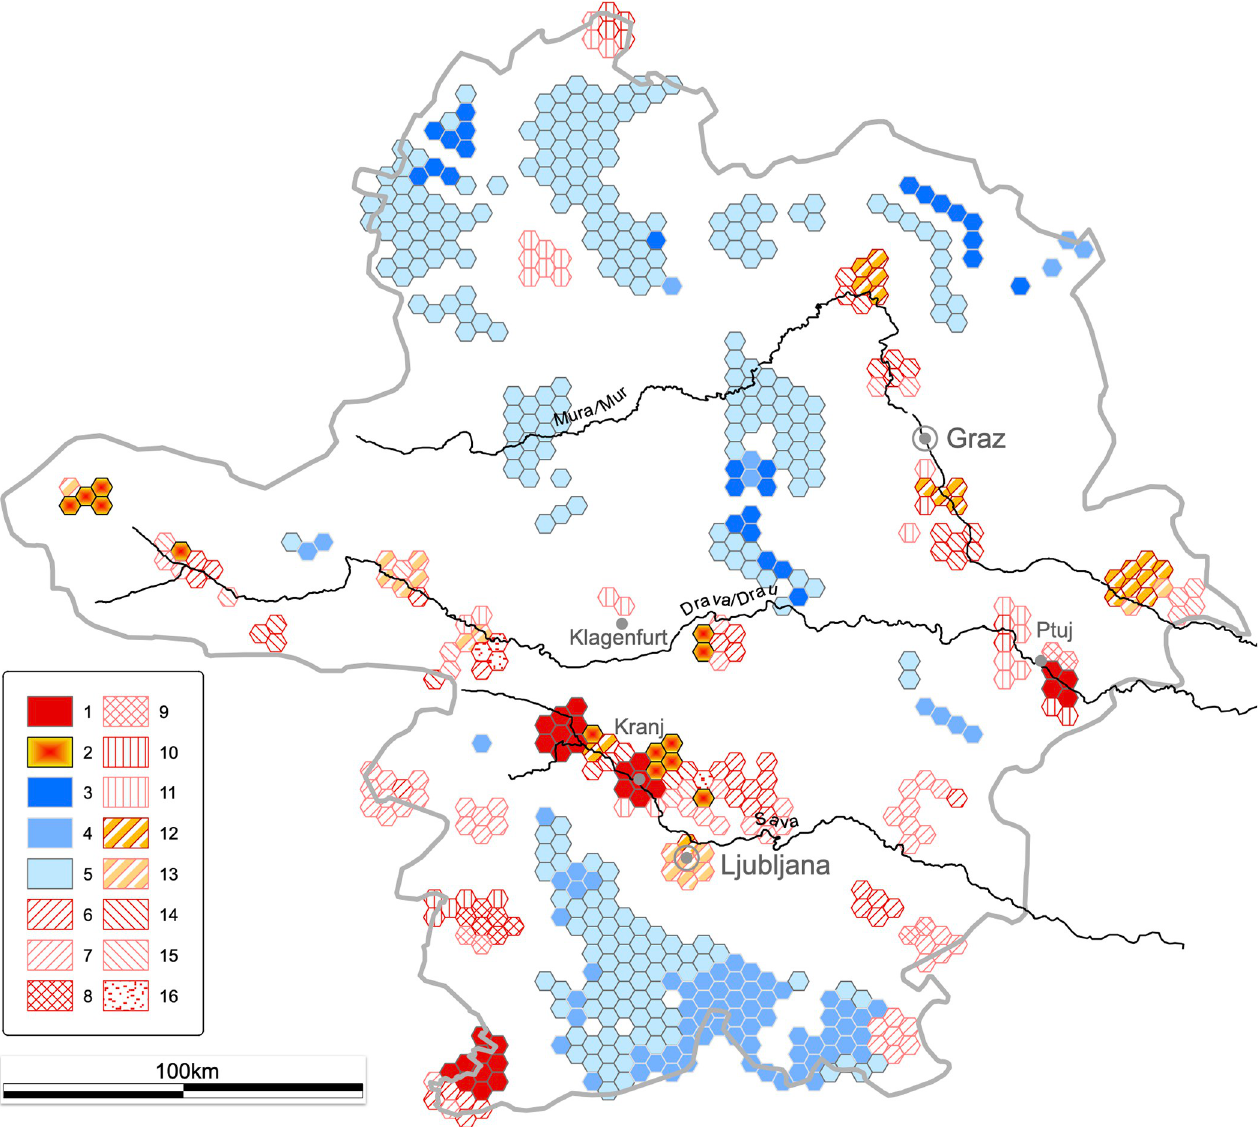
Fig 4. Archaeological trend map of the modified categorization of the multiscale emerging hot spot analysis. See S1 Table for the legend (authors E.L. and B.Sˇ; contains information from OpenStreetMap and OpenStreetMap Foundation, which is made available under the Open Database License; contains information adapted and modified from Copernicus Land Monitoring Service product EU-DEM25, which was produced with funding by the European